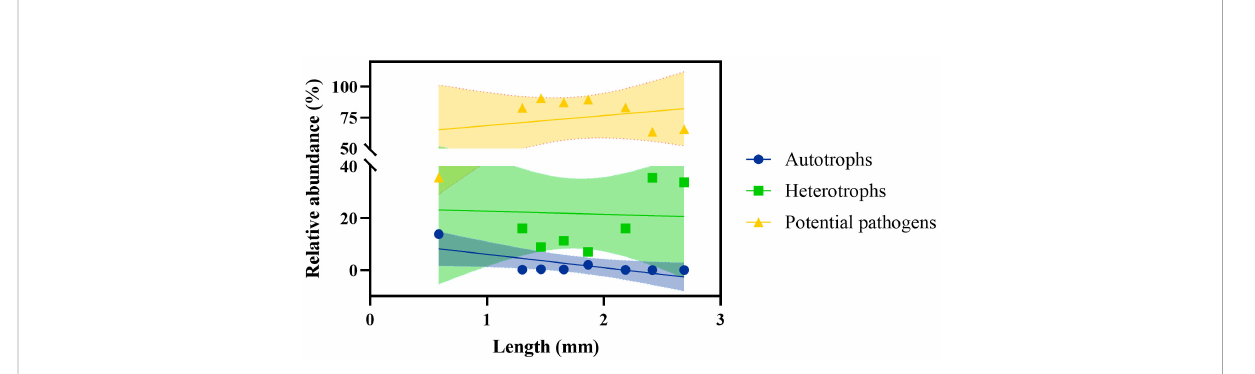
FIGURE 5 Correlation between EAM microbial function and algal length. Dashed lines indicate 95% con fi dence intervals.